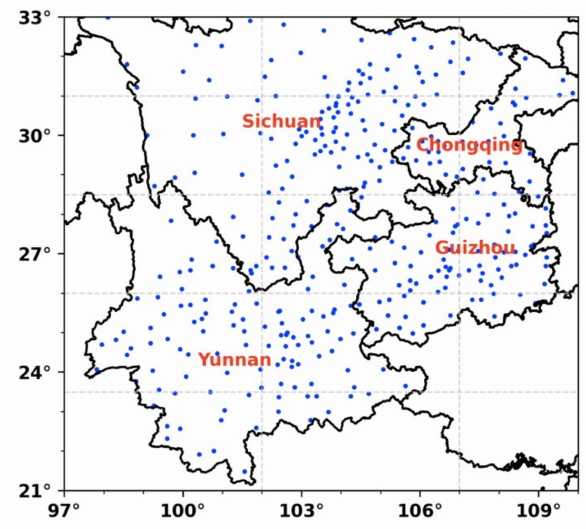
Figure 1. Location distribution of meteorological stations in Southwest